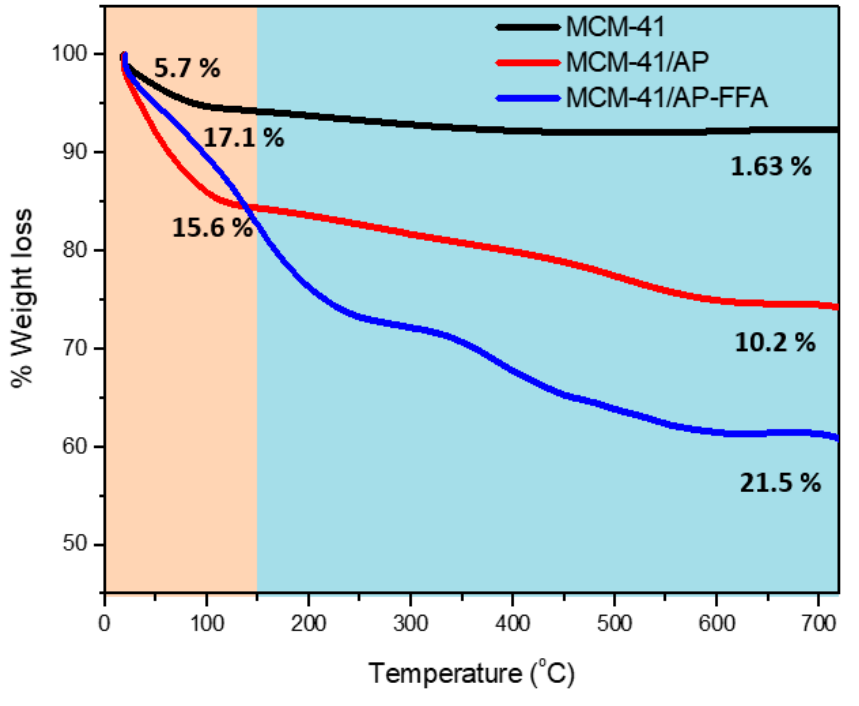
Figure 7. Thermogravimetric analysis (TGA) graph of mass loss (%) of MCM-41, MCM-41/AP, and